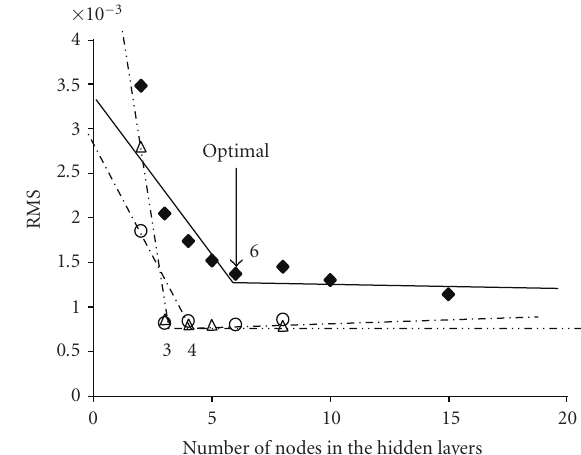
Figure 4: Plot of residual mean squares as a function of the number of nodes in the hidden layers, in the three-layers network ( (cid:2) ), and in the second ( Δ ) and third ( (cid:2) ) layers of the four-layers network. For the networks labelled ( Δ ), 3 nodes were used in the third layer; and for the networks labelled ( (cid:2) ), 4 nodes were used in the second layer. The lines have no physical meaning; they are included to better illustrate the optimal number of